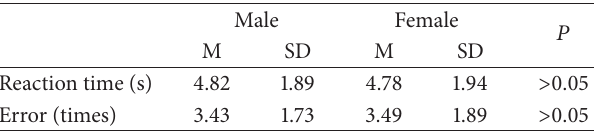
Table2:Visualimageoperationperformanceofsubjectsofdifferent